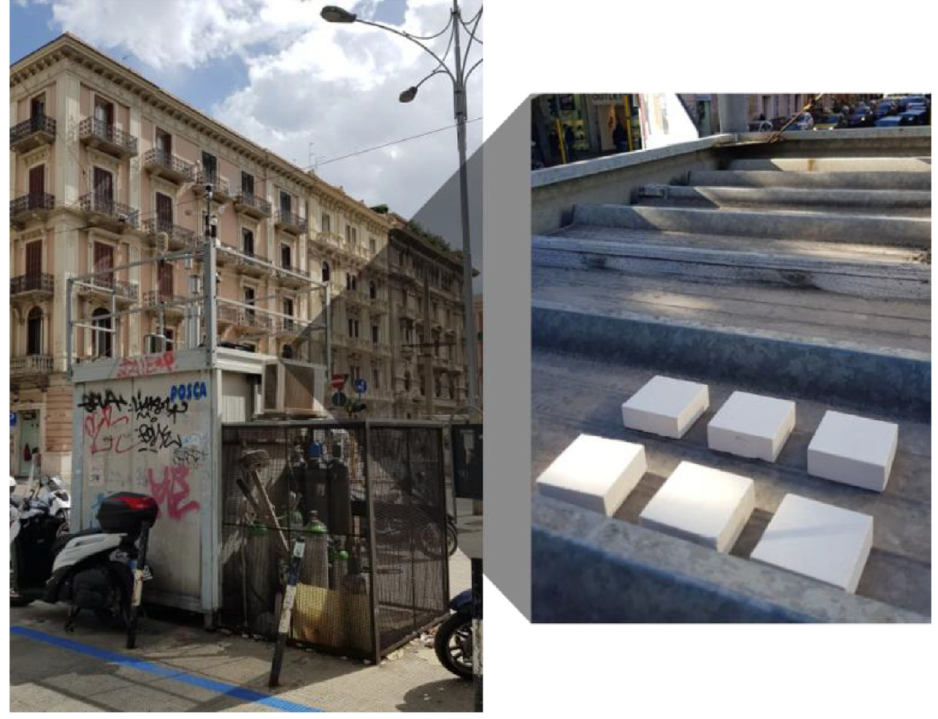
Figure 2. Samples exposed on top of the ARPA (Regional Agency for Environmental Protection) [108] .